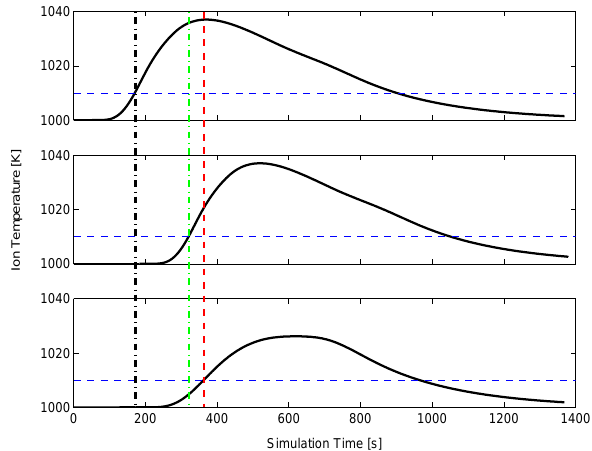
Fig. 3. A three-panel plot showing model ion-temperature time series. The top panel shows data from a simulated station at 10:05 MLT; the middle panel is the same data lagged by 140s; the lower panel is data from a simulated station at 07:49 MLT. The blue dashed lines mark a 1010 K threshold and the vertical lines mark the times that the data series first exceeds the threshold.